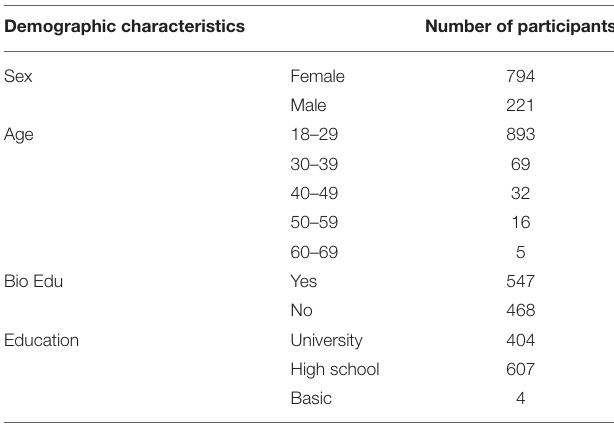
TABLE 2 | Demographic characteristics of participants (bio edu, education in biology).